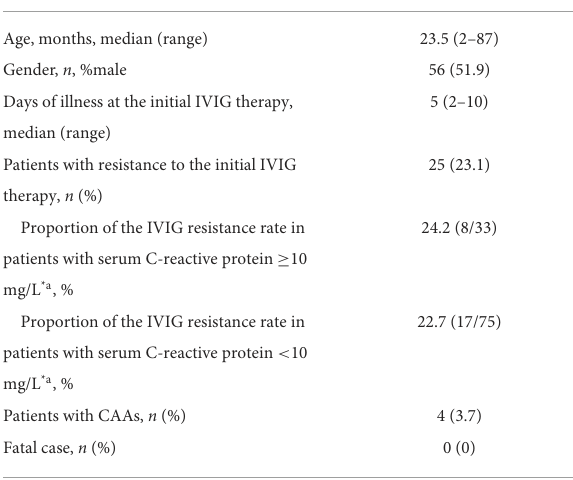
TABLE 1 The demographic and clinical characteristics of KD patients with the initial IVIG therapy.